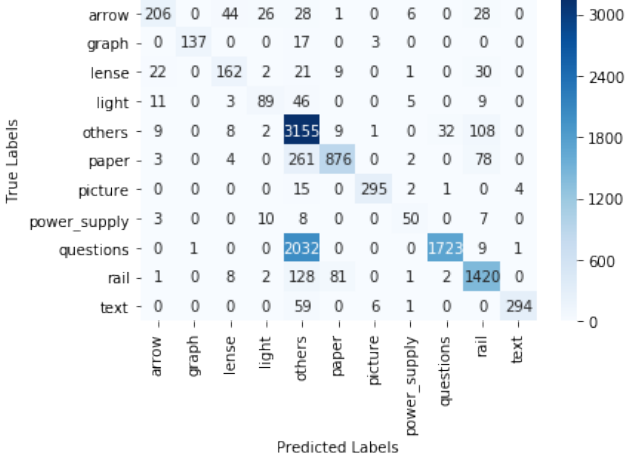
Figure 9. Confusion matrix for Faster R-CNN with interpolation.